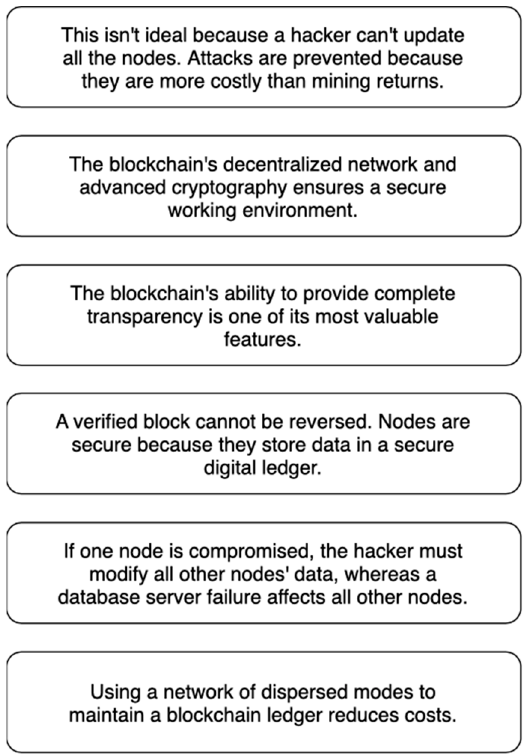
Figure 8. Blockchain—IoT for Smart Transportation.